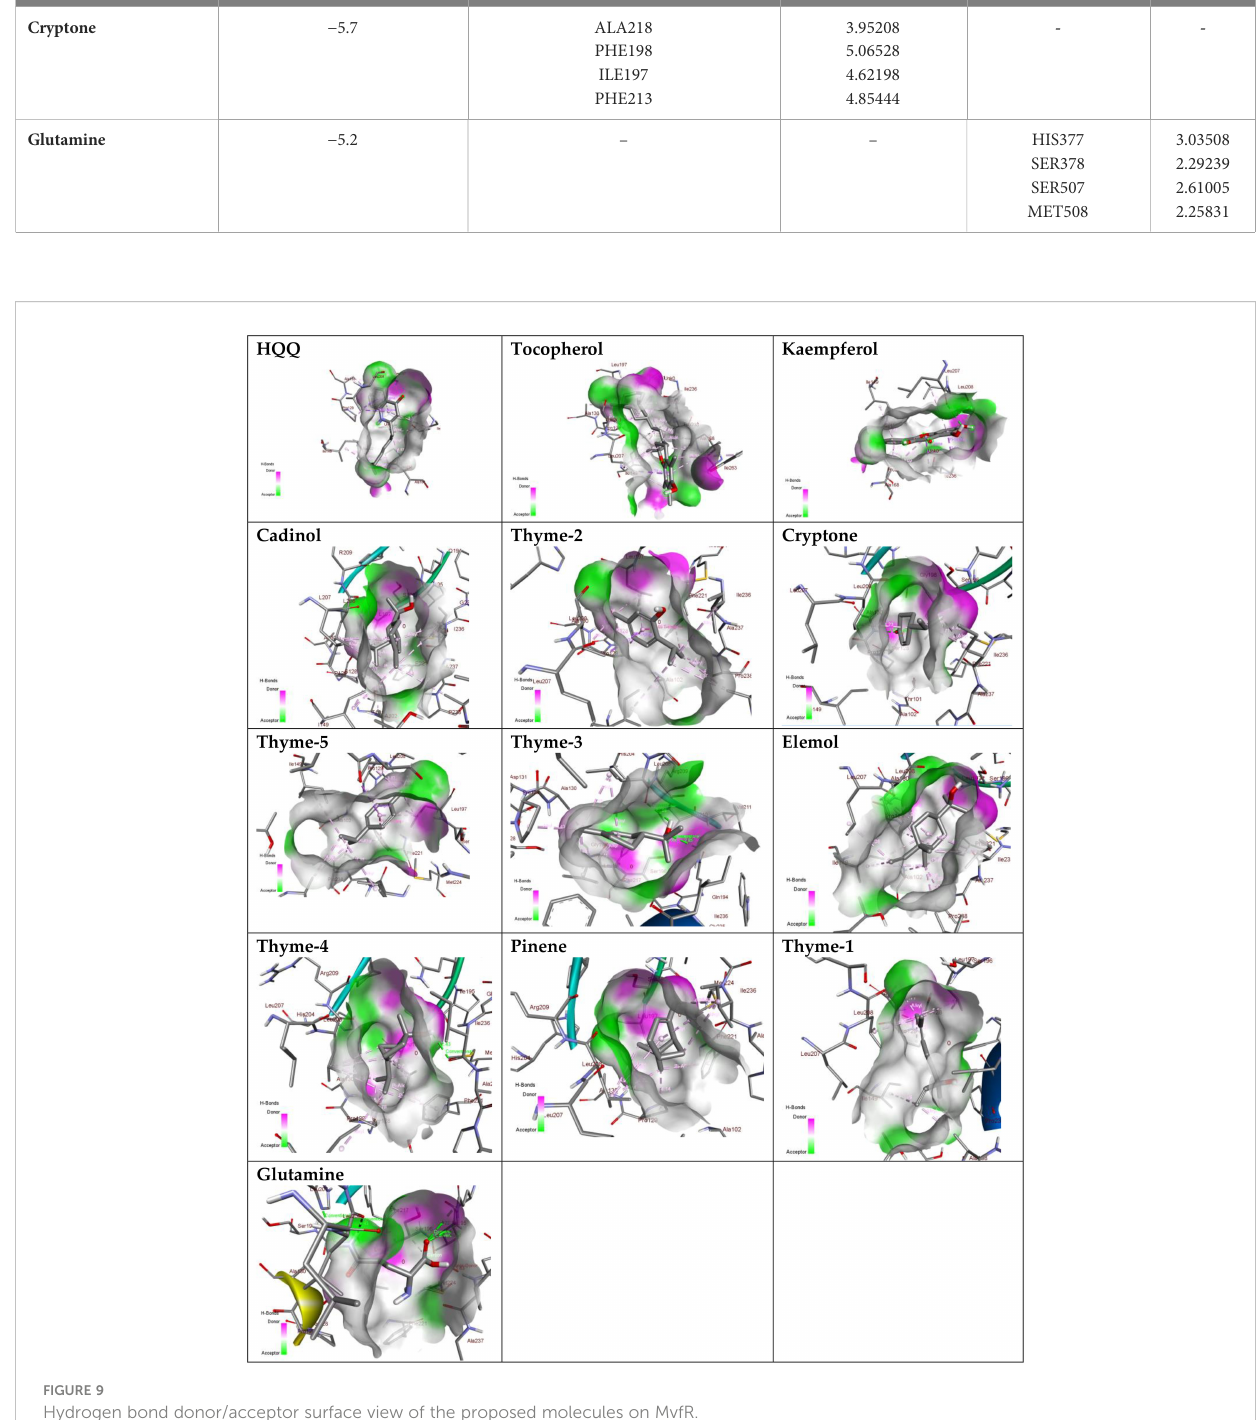
FIGURE 9 Hydrogen bond donor/acceptor surface view of the proposed molecules on